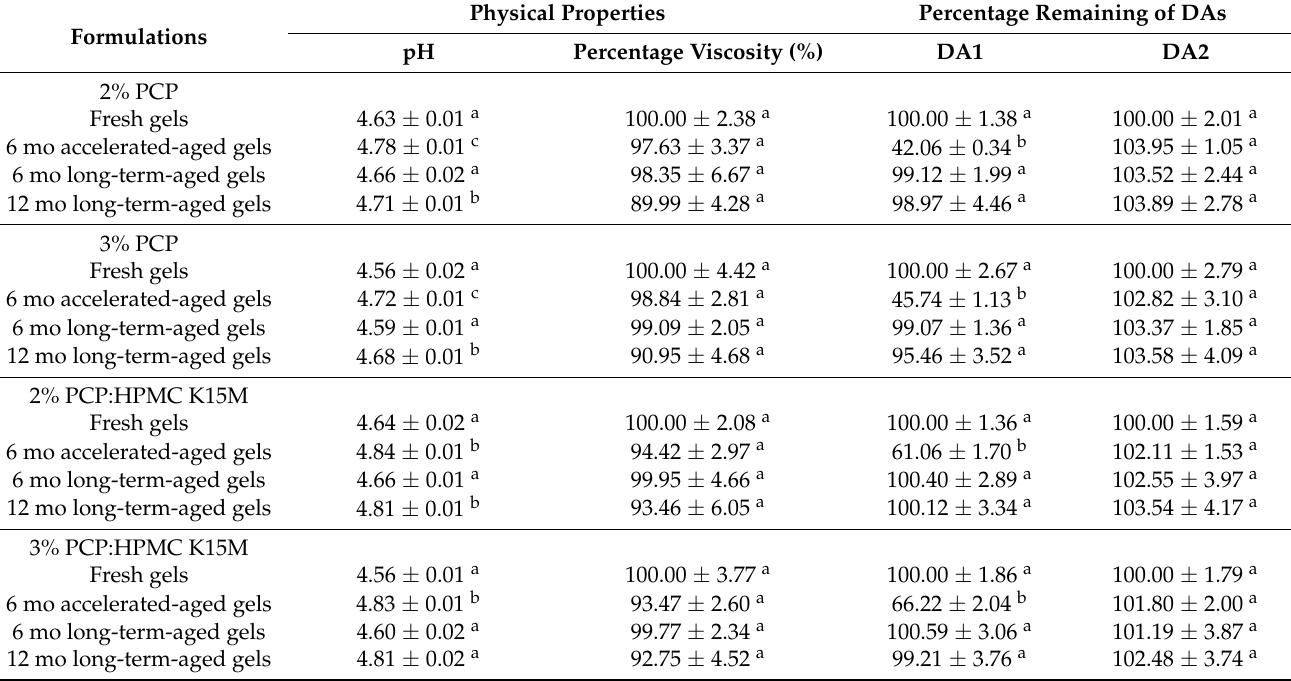
Table 5. Physical and chemical stability of selected C. comosa mucoadhesive gels after storage at 5 ± 3 ◦ C (long-term) and 30 ± 2 ◦ C/75 ± 5% RH (accelerated) conditions after 6 and 12 months, respectively, compared with fresh